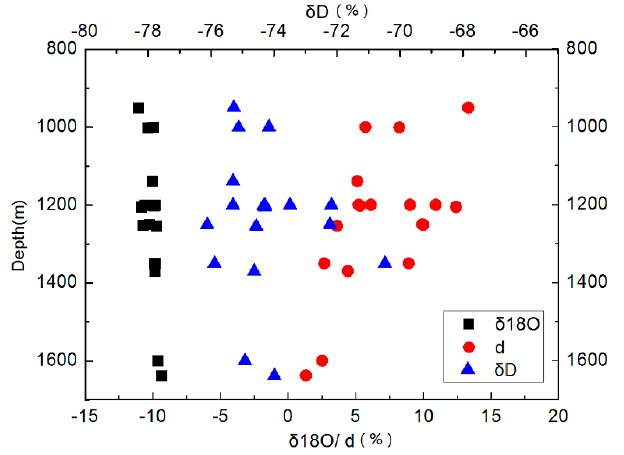
Figure 2. Variations of δ D, δ 18 O, and d value of deep geothermal water with depths in Kaifeng.